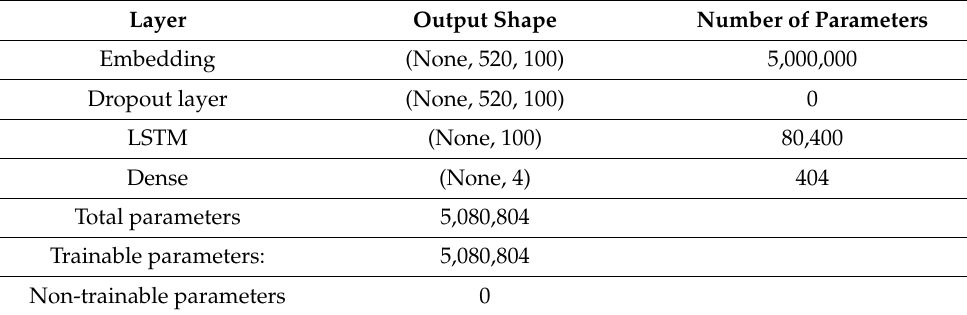
Table 3. Details of long short-term memory (LSTM)